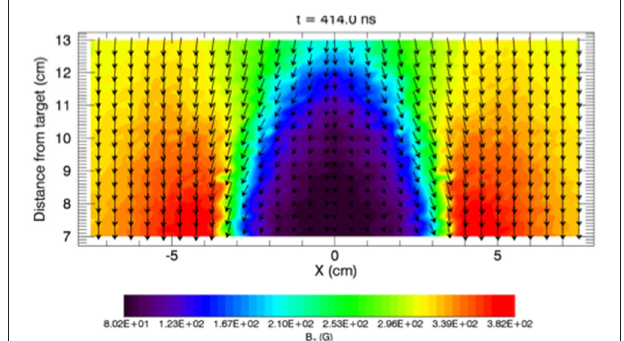
FIGURE 12 | Magnetic probe measurements of the magnetic field direction and magnitude (arrows) produced by a low Mach number (M A ∼ 1) expansion of target ions with laser beam oriented along the background magnetic field. The magnetic cavity (purple region) forms just in front of the target (Heuer et al., 2018, private